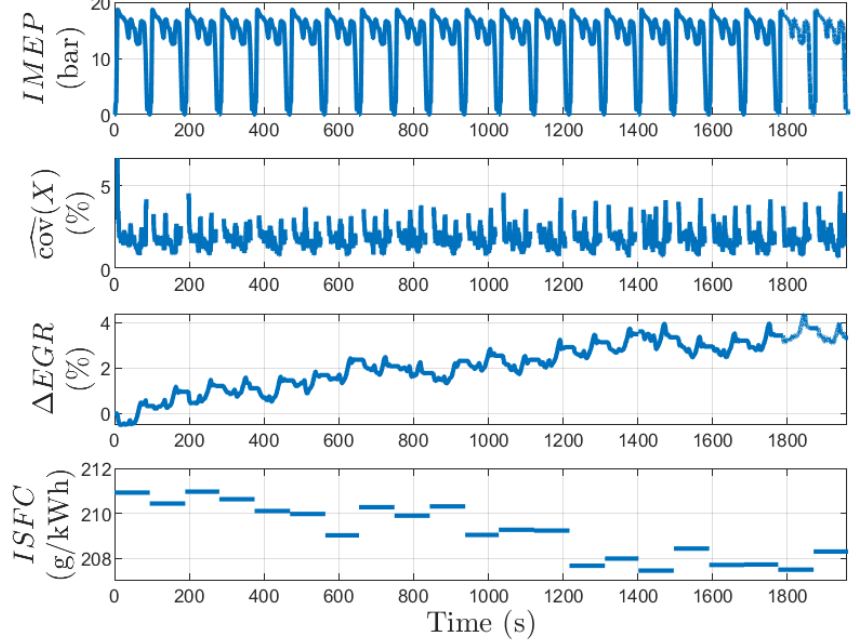
Figure 8. Control of the EGR offset subject to repeated pattern of a portion of WLTP